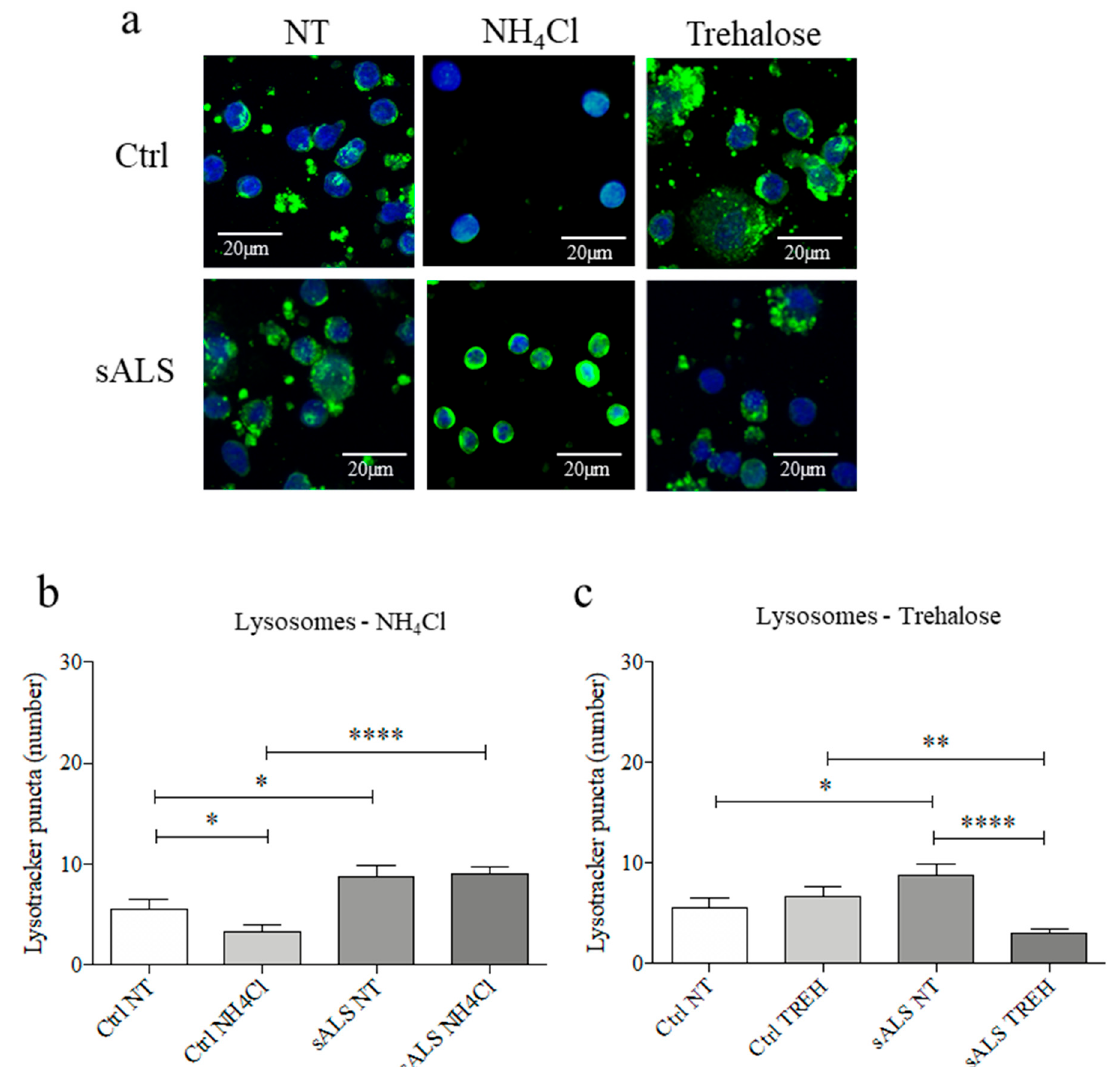
Figure 5. Trehalose proves to help to remove accumulated lysosomes. ( a ) Immunofluorescence analysis of LysoTracker™ in sALS patients and healthy controls treated and non-treated with NH4Cl or Tehalose; Scale bar: 20 μ m. N = 3 ( b ) ImageJ quantification of LysoTracker™ puncta. We found statistically significant differences between Ctrl NT and sALS NT, CTRL NT and CTRL NH4Cl (* p < 0.05) and Ctrl NH4Cl and sALS NH4Cl (**** p < 0.0001). ( c ) ImageJ analysis of LysoTracker™ puncta. We found statistically significant differences between Ctrl NT and sALS NT (* p < 0.05), CTRL TREH and SALS TREH (** p < 0.01) SALS NT and sALS TREH (**** p <